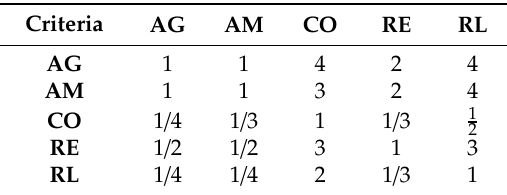
Table 3. Real number